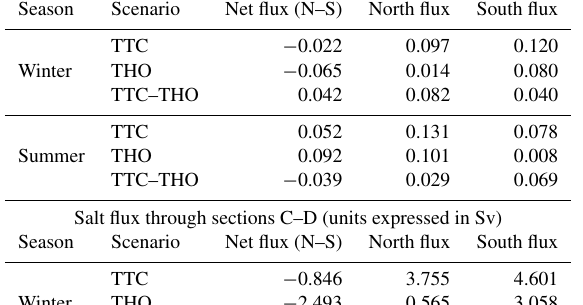
Table 3. Water, salt and heat fluxes through sections C–D computed for winter and summer periods from THO and TTC scenario results and differences (TTC–THO). Water and salt fluxes are expressed in Sv, heat fluxes in 10 7 W. The south flux and north flux are con- sidered as absolute values. The net flux (N–S) values are obtained as the differences between north flux and south flux values. Posi- tive values indicate a northward net flux; negative values indicate a southward net